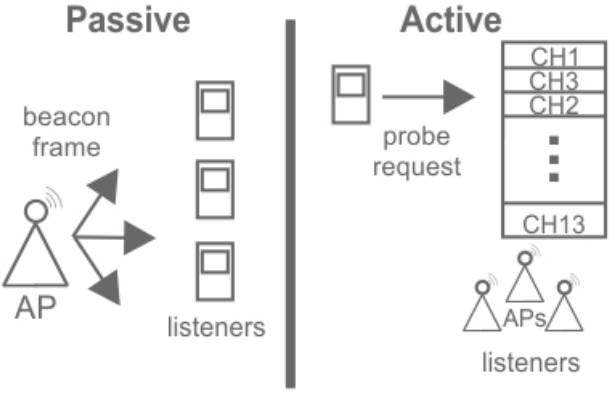
Figure 3. Passive and active